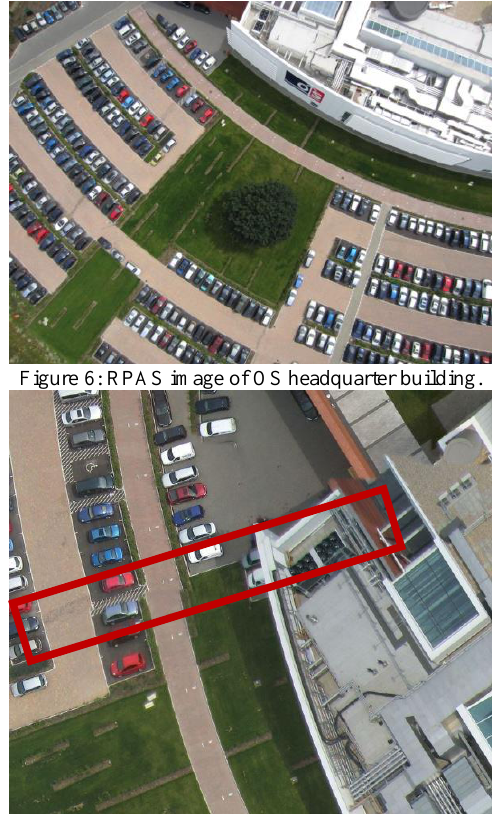
Figure 7: Fast mapping ortho